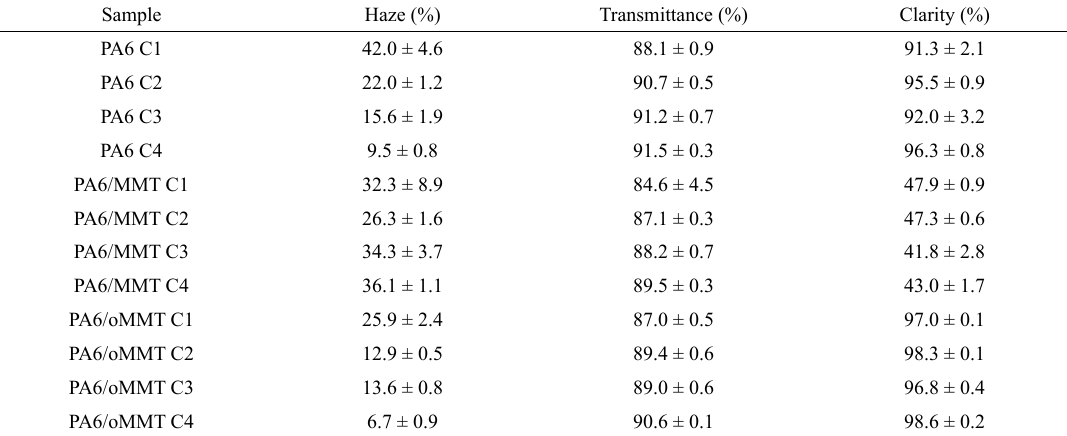
Figure 5. TEM micrographs of the PA6/oMMT blown films obtained in different processing conditions: (a) C1; (b) C2; (c) C3; (d) C4. Table 4. Optical properties of the blown